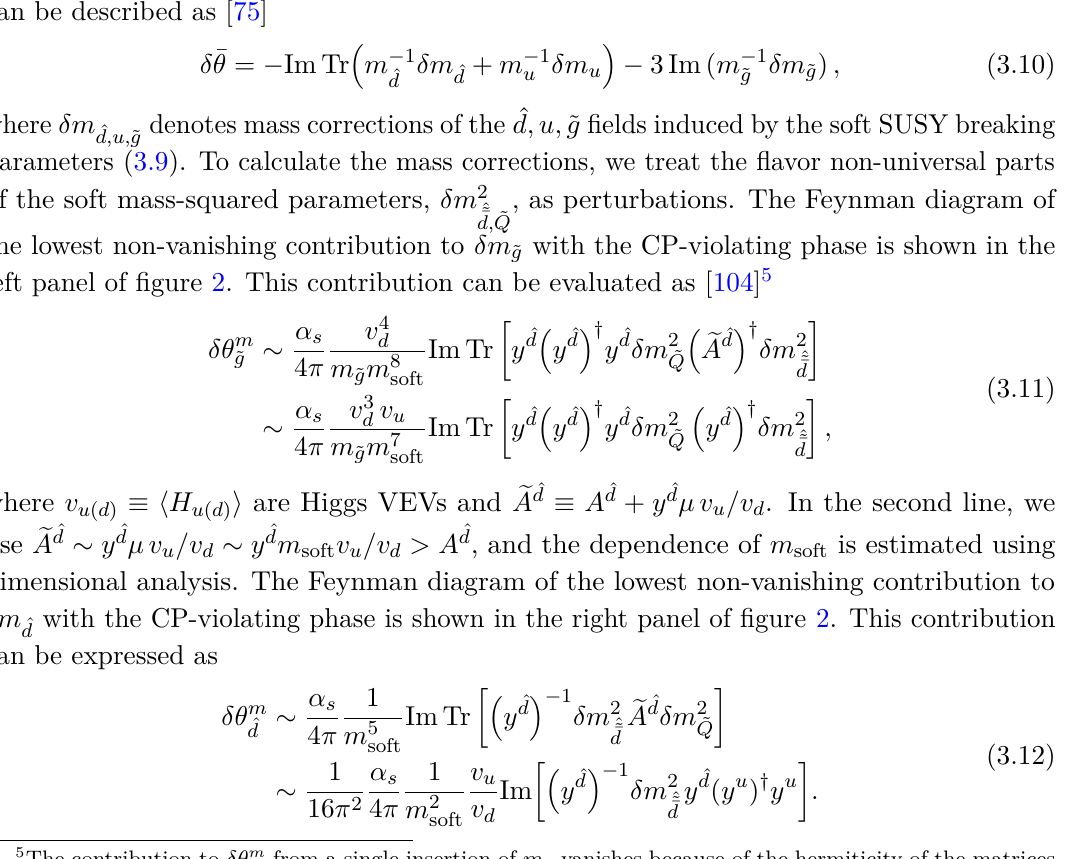
Figure 1 . The soft mass-squared parameters m 2 by the effective Kähler potential obtained in eqs. (3.4), (3.5). The cross denotes the insertion of the F -term of a SUSY breaking